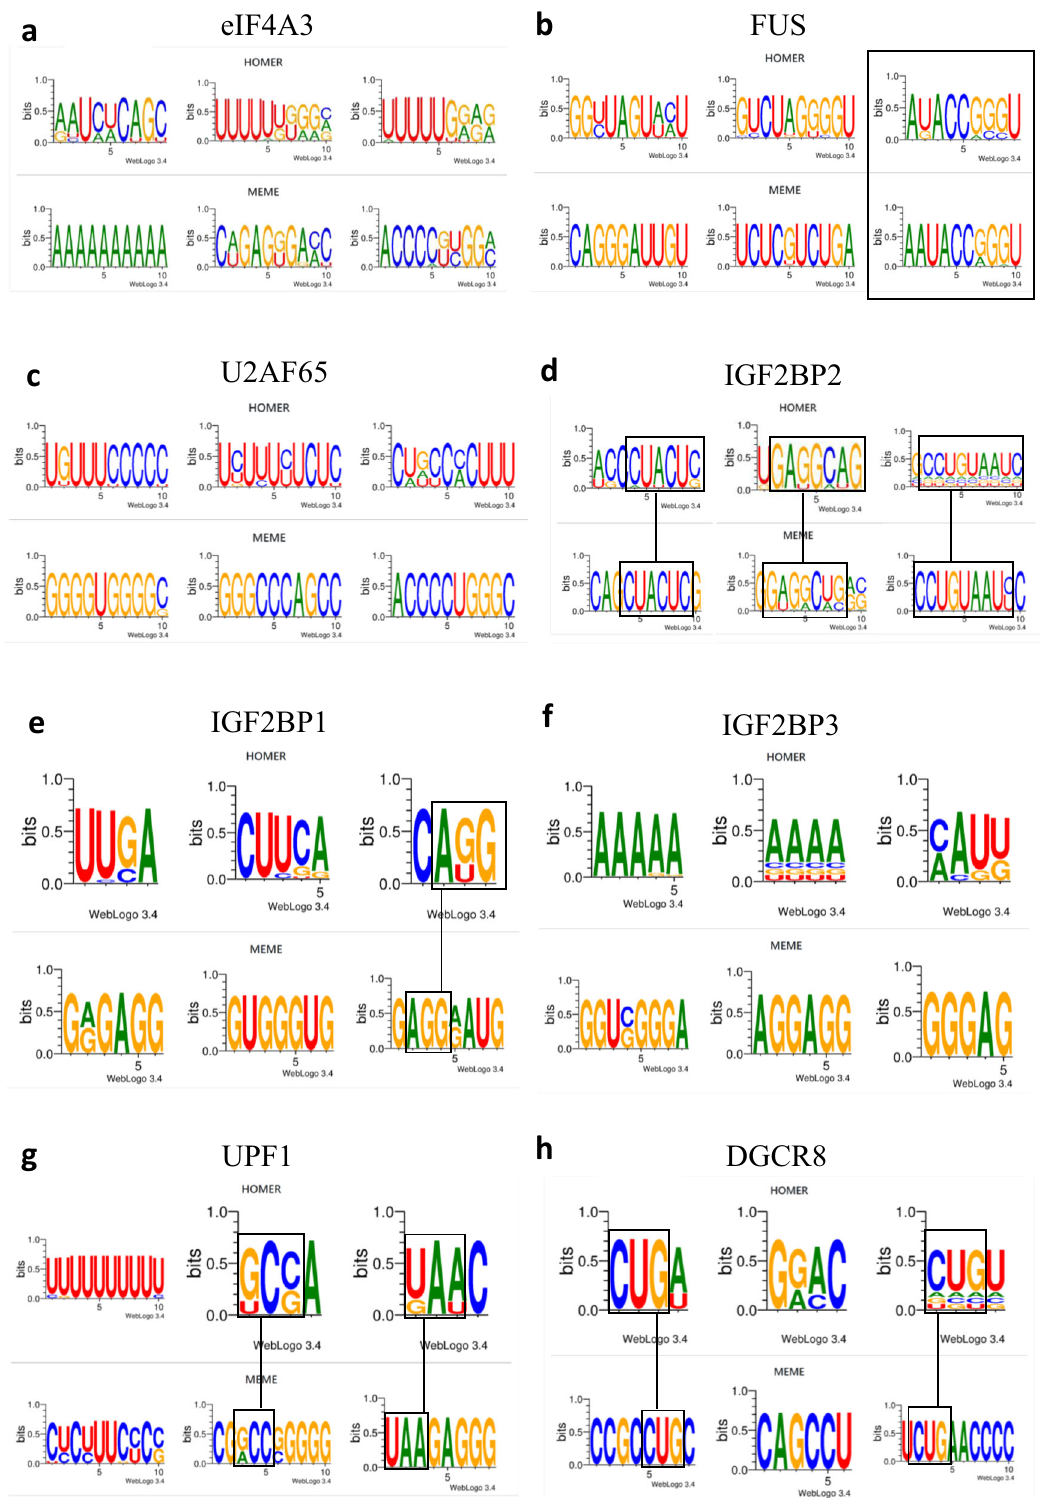
Fig. 4 Putative consensus motifs in lncRNAs for the speci fi c binding of key RNA-binding proteins. Data extracted from POSTAR3 database (CLIPseq-based) 141 and processed by HOMER and MEME algorithms that are commonly used for motif discovery and next-generation sequencing (NGS) data analysis. Square boxes highlight similar patterns identi fi ed in the motifs provided by both algorithms. a Consensus motif for binding of RNA-binding protein eIF4A3 (eukaryotic initiation factor 4A-III). b Consensus motif for binding of RNA-binding protein FUS (fused in sarcoma). c Consensus motif for binding of RNA-binding protein U2AF65 (splicing factor U2AF 65kDa subunit). d Consensus motif for binding of RNA- binding protein IGF2BP2 (insulin-like growth factor 2 mRNA-binding protein 2). e Consensus motif for binding of RNA-binding protein IGF2BP1 (insulin-like growth factor 2 mRNA-binding protein 1). f Consensus motif for binding of RNA-binding protein IGF2BP3 (insulin-like growth factor 2 mRNA-binding protein 3). g Consensus motif for binding of RNA-binding protein UPF1 (regulator of nonsense transcripts 1). h Consensus motif for binding of RNA-binding protein DGCR8 (microprocessor complex subunit DGCR8, DiGeorge syndrome critical region